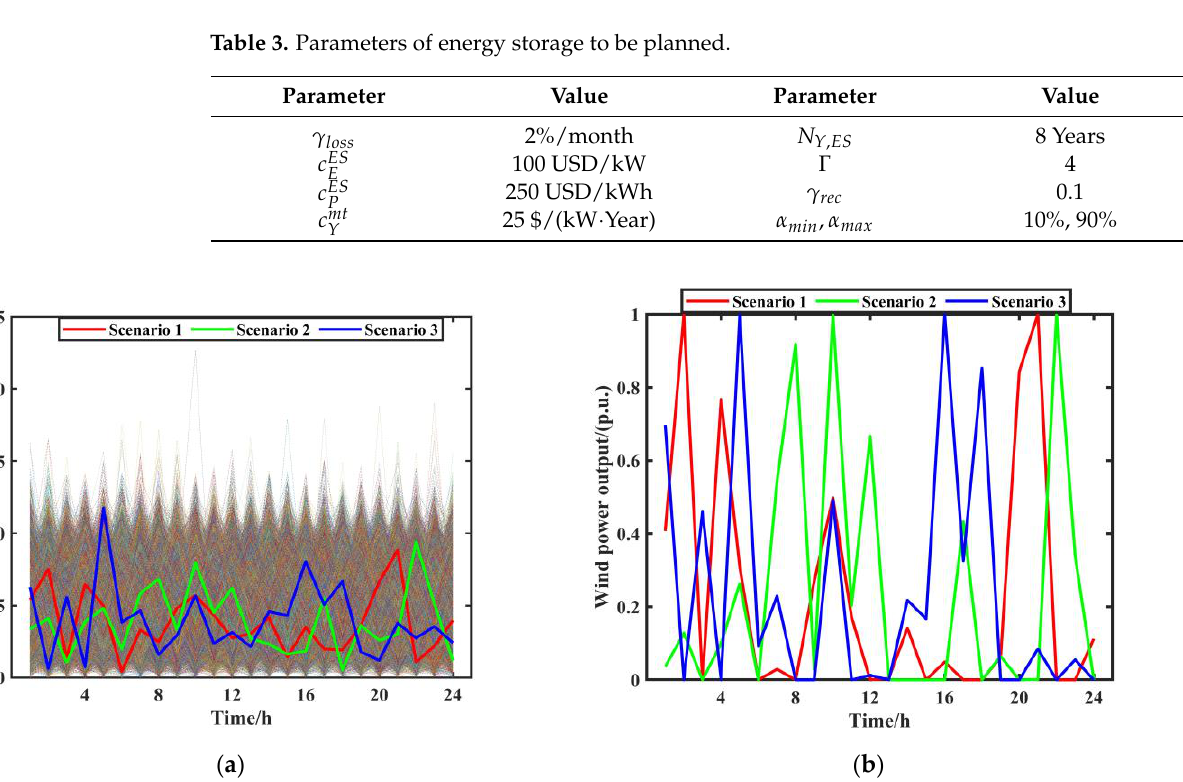
Figure 3. ( a ) Wind speed before and after the scenario reduction; ( b ) wind power output of reduced scenarios.